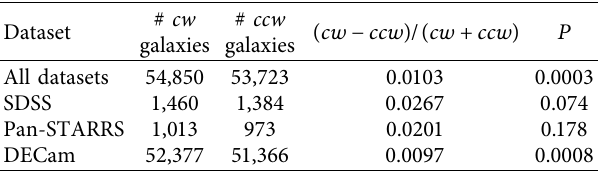
Table 10: Number of clockwise and counterclockwise galaxies in the 40 o × 40 o region centered around the CMB Cold Spot. The P value is the binomial probability to have an equal or stronger distribution by mere